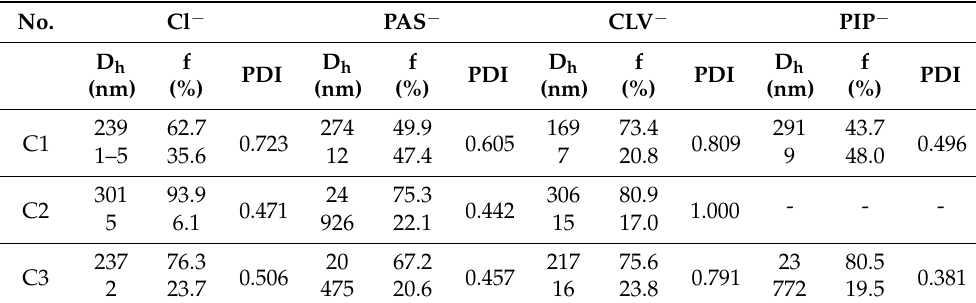
Table 3. Hydrodynamic diameters of poly(ionic liquid) (PIL) particles determined by dynamic light scattering (DLS) a